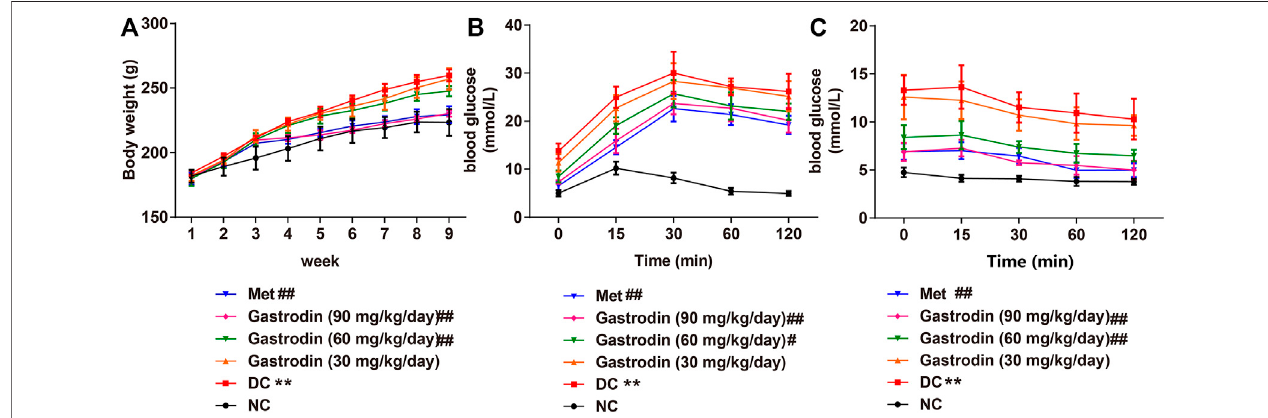
FIGURE 1 | The effects of Gastrodin on body weight, OGTT and ITT in T2DM rats. Body weight (A) , oral glucose tolerance test curve of each group (B) and insulin tolerance test curve of each group of each group (C) . The results were presented as mean ± SD ( n (cid:1) 6). ** p < 0.01, vs. NC group, # p < 0.05, ## p < 0.01, vs. DC group.